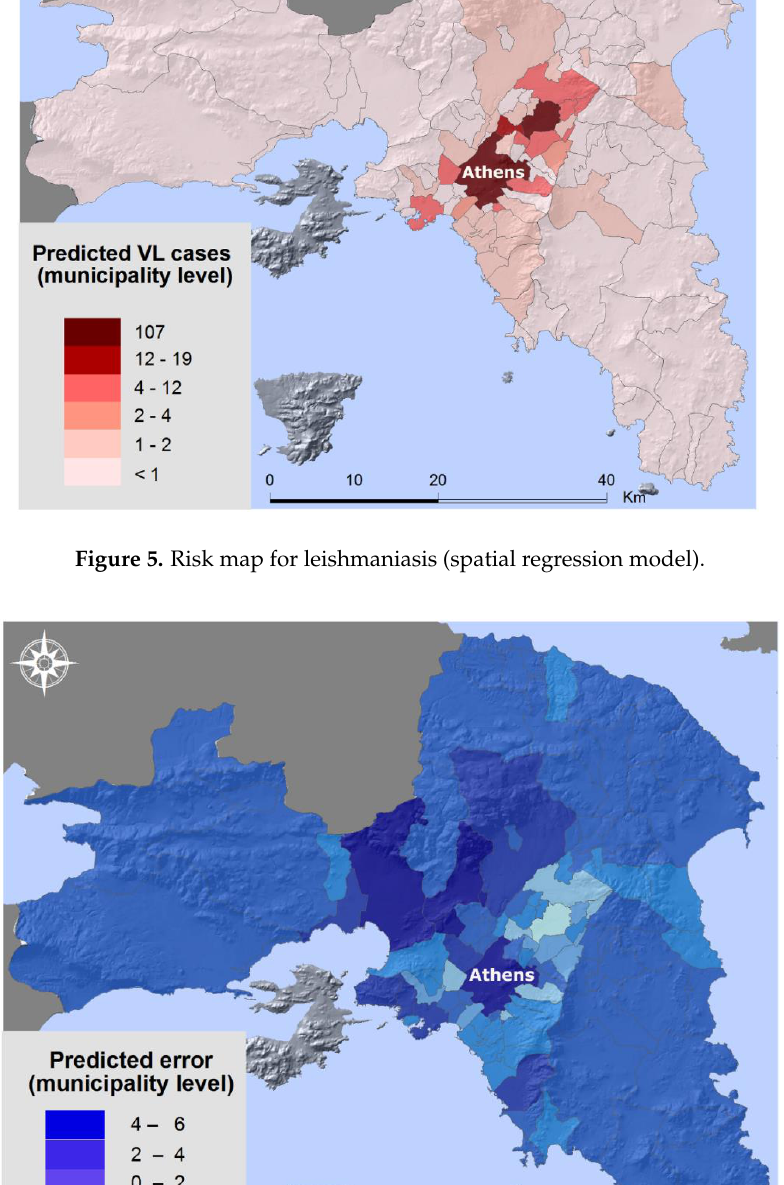
Figure 6. Prediction error (spatial regression model).